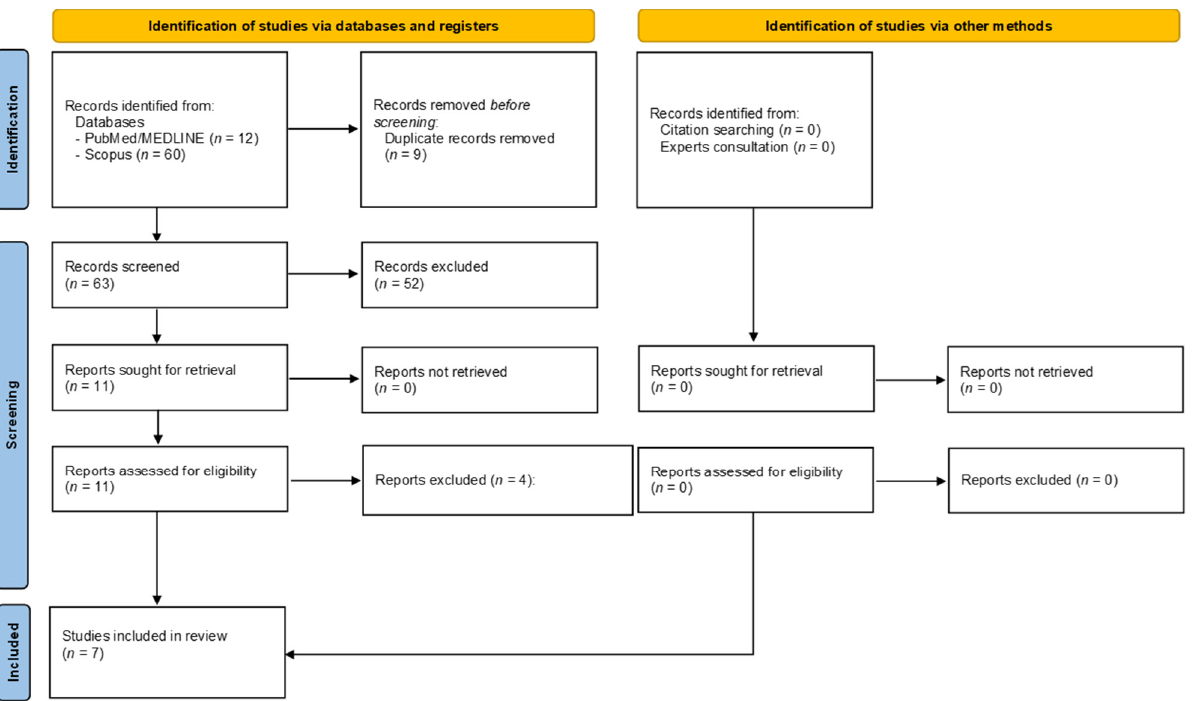
Figure 1. Flow diagram depicting the selection process.